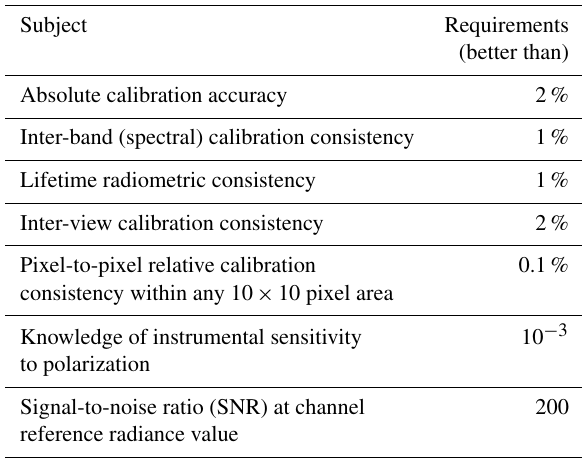
Table 1. Specification of the radiometric accuracy for the 3MI in- strument (summarized from Fougnie et al.,